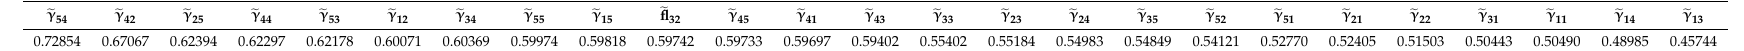
Table 3. Arrangement of order of grey correlation degrees for digital